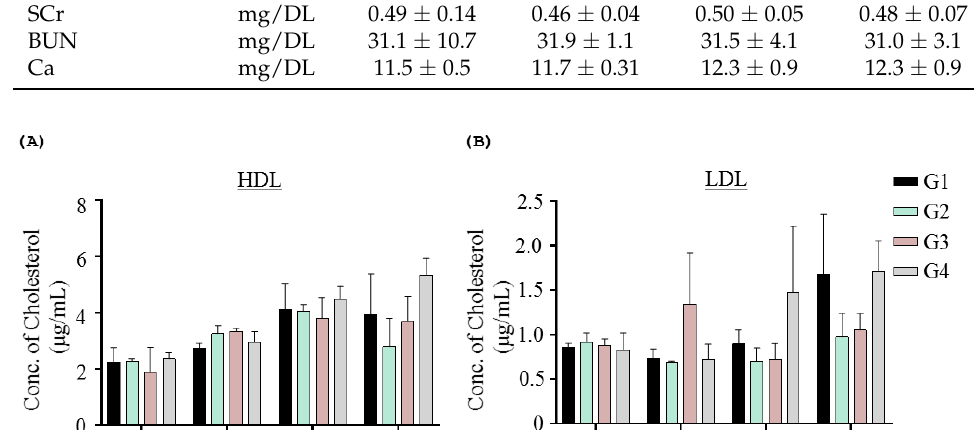
Figure 4. Effect of INO95 and INO20 on cholesterol level in the repeated dose toxicity study. In the experiment, blood samples were collected every four weeks to examine cholesterol level including HDL and LDL. The comparisons of HDL ( A ) and LDL ( B ) level of each group for 13-week treatment are presented. The data shown represent mean ± S.D. ( n = 5).